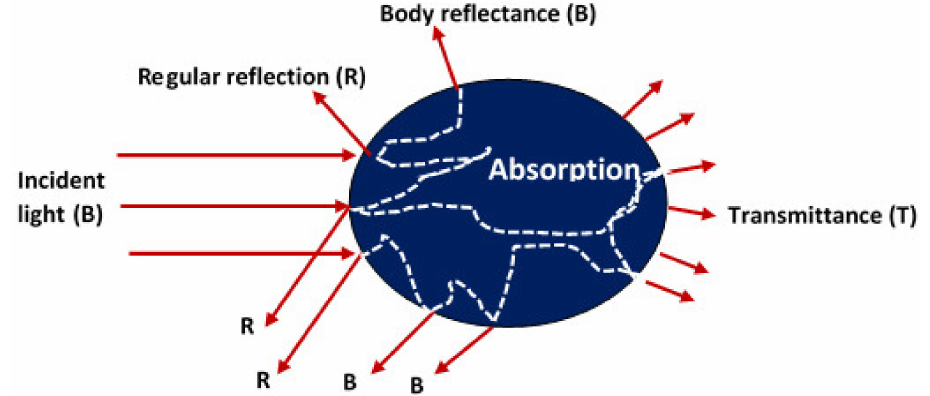
Figure 4. Distribution of incident light on an object showing the reflectance, absorbance and